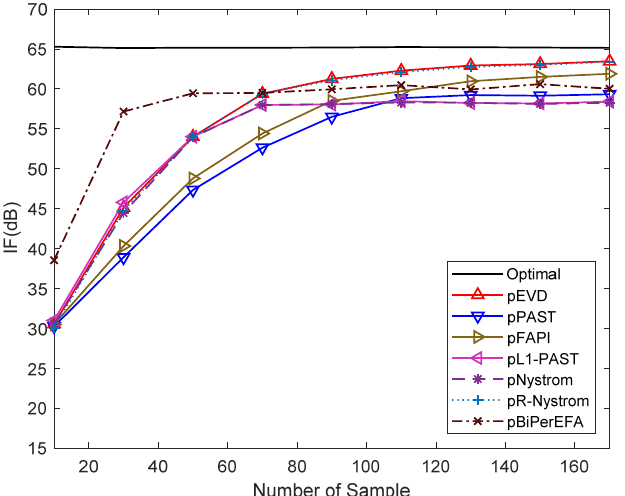
Figure 4. Signal to clutter plus noise ratio (SCNR) loss performance versus training samples.